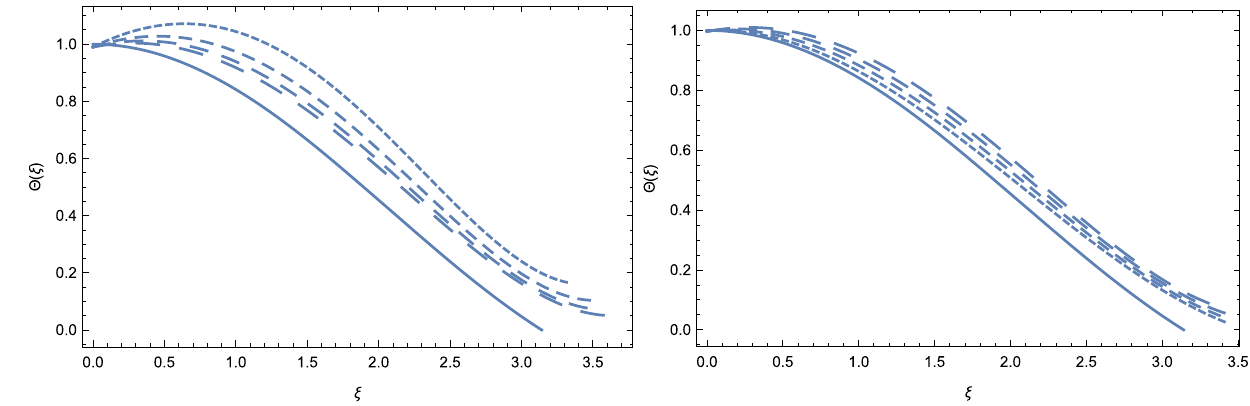
Fig. 1 Variation of the dimensionless dark matter density (cid:20)(ξ) as a function of the dimensionless radial distance ξ , for different model parameters.IntheleftFigure, θ = 0 . 01, γ = 2, (cid:2) = 0 . 3, ρ bc /ρ c = 0 . 2, while σ = 0 . 01 (dotted curve), σ = 0 . 015 (short dashed curve), σ = 0 . 02 (dashed curve), and σ = 0 . 025 (long dashed curve), respec- tively. In the right Figure, σ = 0 . 01, γ = 2, (cid:2) = 0 . 3, ρ bc /ρ c = 0 . 2,